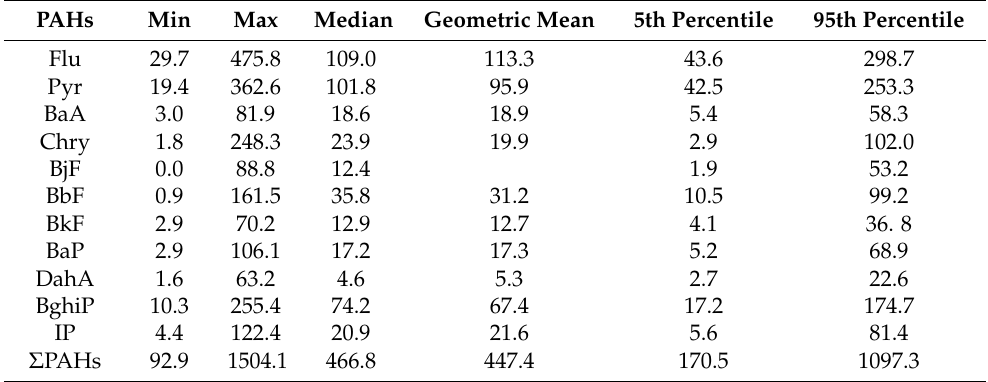
Table 1. Summary data of PAH mass fractions (ng g − 1 ) in household dust samples from the city of